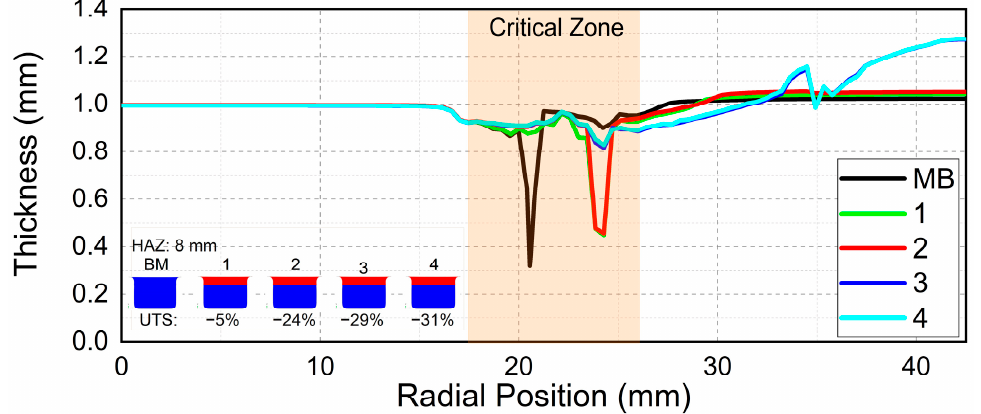
Figure 10. Comparison of component final thickness evolution along radial extension for different degrees of material softening with a HAZ of 8 mm.